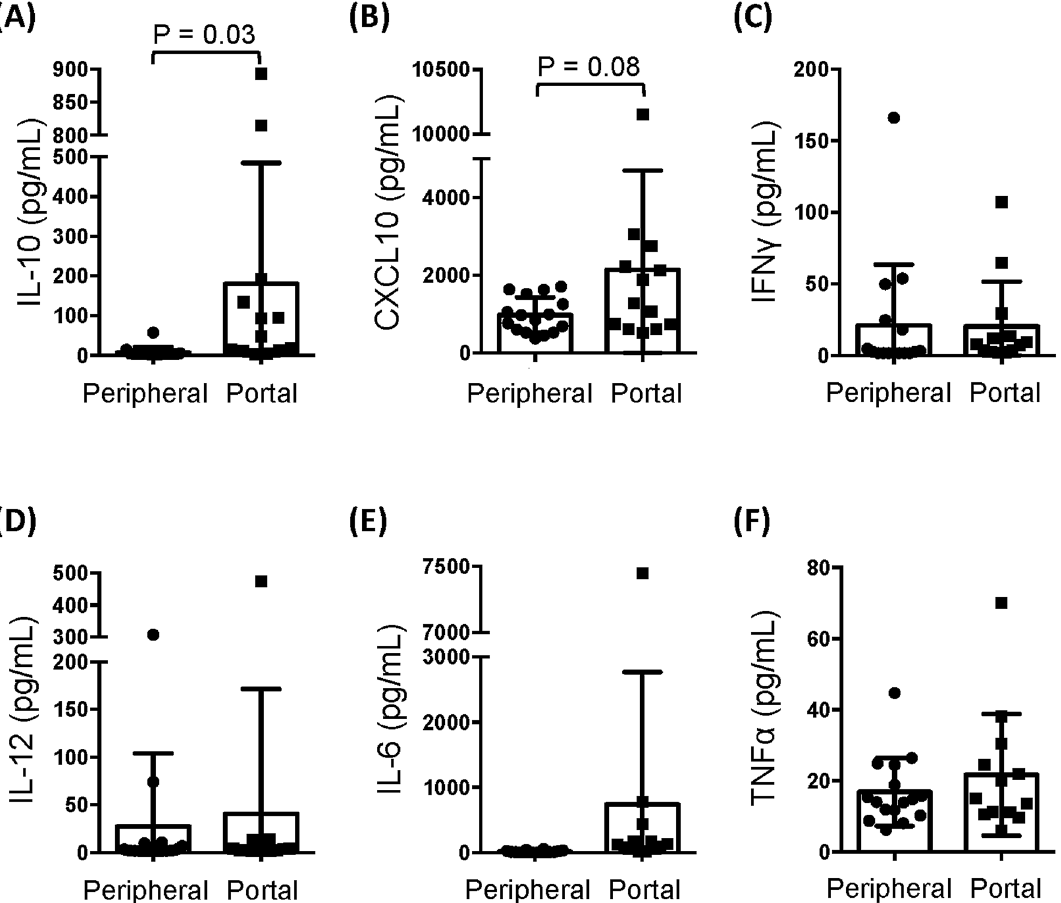
Figure 7. Portal vein blood has a higher concentration of IL-10 than peripheral blood. Portal vein plasma and peripheral plasma was analyzed for concentrations of (A) IL-10, (B) CXCL10, (C) IFNγ, (D) IL-12, (E) IL-6, and (F) TNFα. Horizontal bars depict the mean ± SD. N = 16 peripheral plasma, n = 13 portal vein plasma by unpaired t